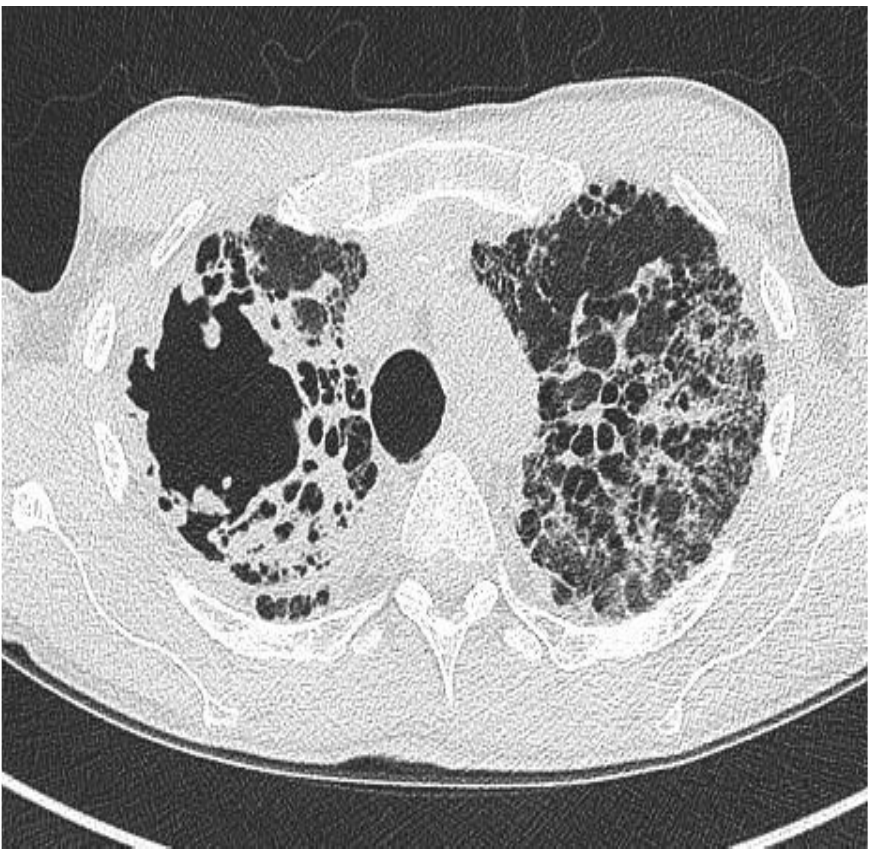
Figure 3. Chronic pulmonary aspergillosis in a patient with bronchiectasis mainly involving the upper lobes.